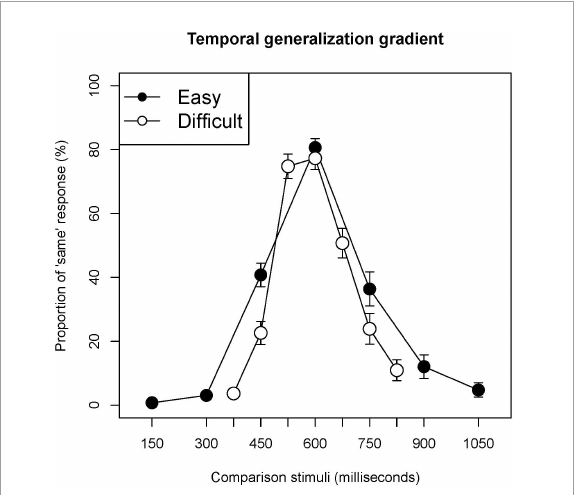
FIGURE1 Temporal generalization gradients. Filled and open circles indicate the proportion of “same” responses corresponding to each stimulus under the easy and difficult conditions, respectively. Error bars are standard error.